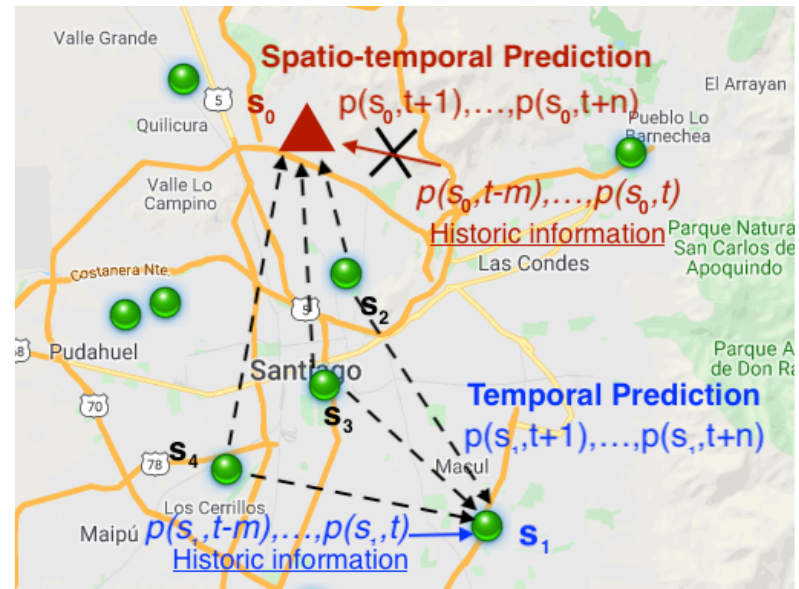
Figure 1. Temporal prediction vs. spatio-temporal prediction. Green points indicate the sites of monitoring stations where historical information (pollution and meteorological variables) is available, p ( s 1 , t m ) , . . . , p ( s 1 , t ) for a target point s 1 , and temporal predictions at time t + 1, . . . , t + n can be − made at the same points. The red triangle indicates a point where the is not a monitoring station. In this case, the proposed model uses the past (temporal and spatial) information of the other stations for providing the spatio-temporal prediction p ( s 0 , t + 1 ) , . . . , p ( s 0 , t + n )